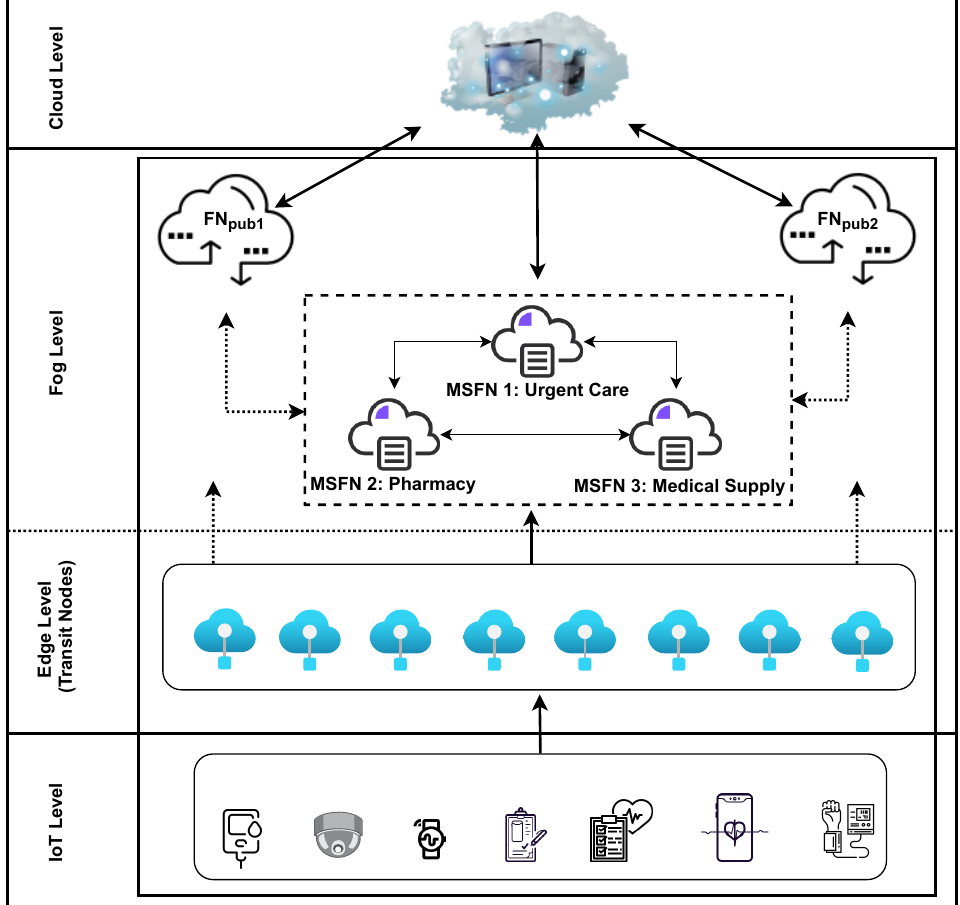
Figure 4. The proposed architecture for the second model.